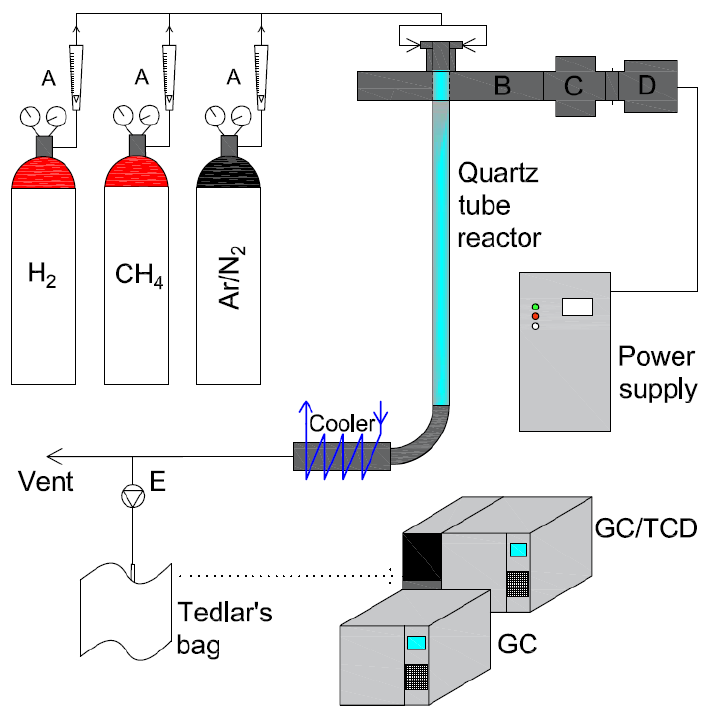
Figure 10. Scheme of the test rig. A—rotameters, B—MW plasma reactor’s waveguide, C—MW plasma reactor’s circulator and reflectometer, D—MW plasma reactor’s generator, E— diaphragm pump. Table 3. Parameters of the GC